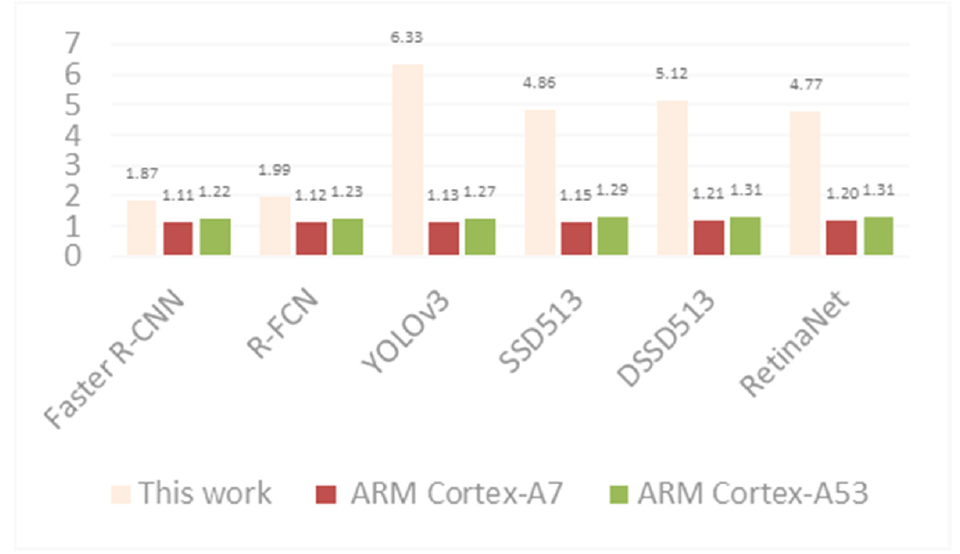
Figure 11. Comparison of the acceleration performance.